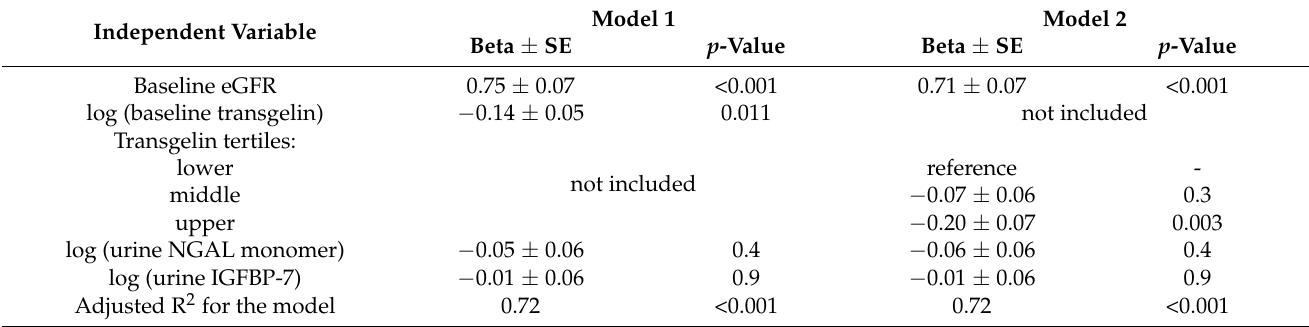
Table 3. Linear regression models to predict eGFR (CKD-EPI Cr ) values at the end of observation (median follow-up of 21 months) among 126 patients with MM. In Model 1, serum transgelin was included as a continuous variable after log-transformation, while in Model 2, serum transgelin was included after categorization into tertiles (the tertiles’ boundaries were 71.0 and 110.6 ng/mL). Model 1 Model Independent Variable